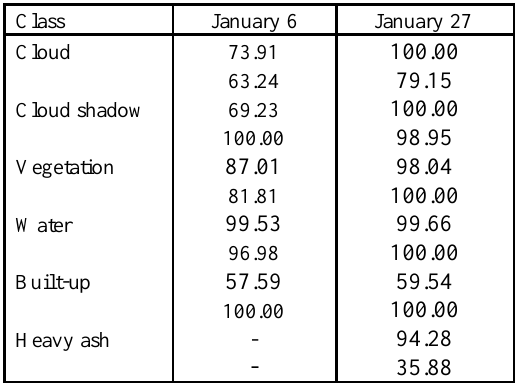
Table 4 . User’s accuracy (top) and Producer’s accuracy (bottom) of each class